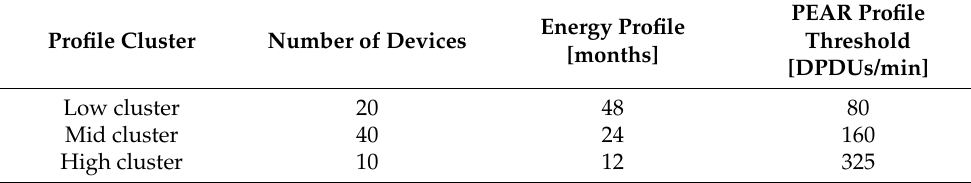
Table 6. The three profile cluster scenario parameters.